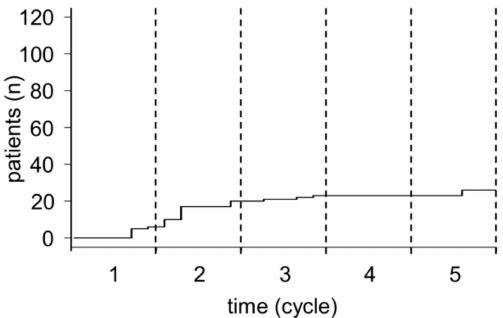
Figure 2. Time-line of HACA development during treatment with ch14.18/CHO. Serum samples collected from 122 pts treated with up to five cycles of ch14.18/CHO immunotherapy were analyzed in every cycle with a validated ELISA allowing for the detection of anti-ch14.18/CHO Abs (HACA). The cumulative incidence of HACA in treated pts during the treatment period is shown over time (black solid line). For a better overview, the end of the respective cycle is indicated by dashed vertical